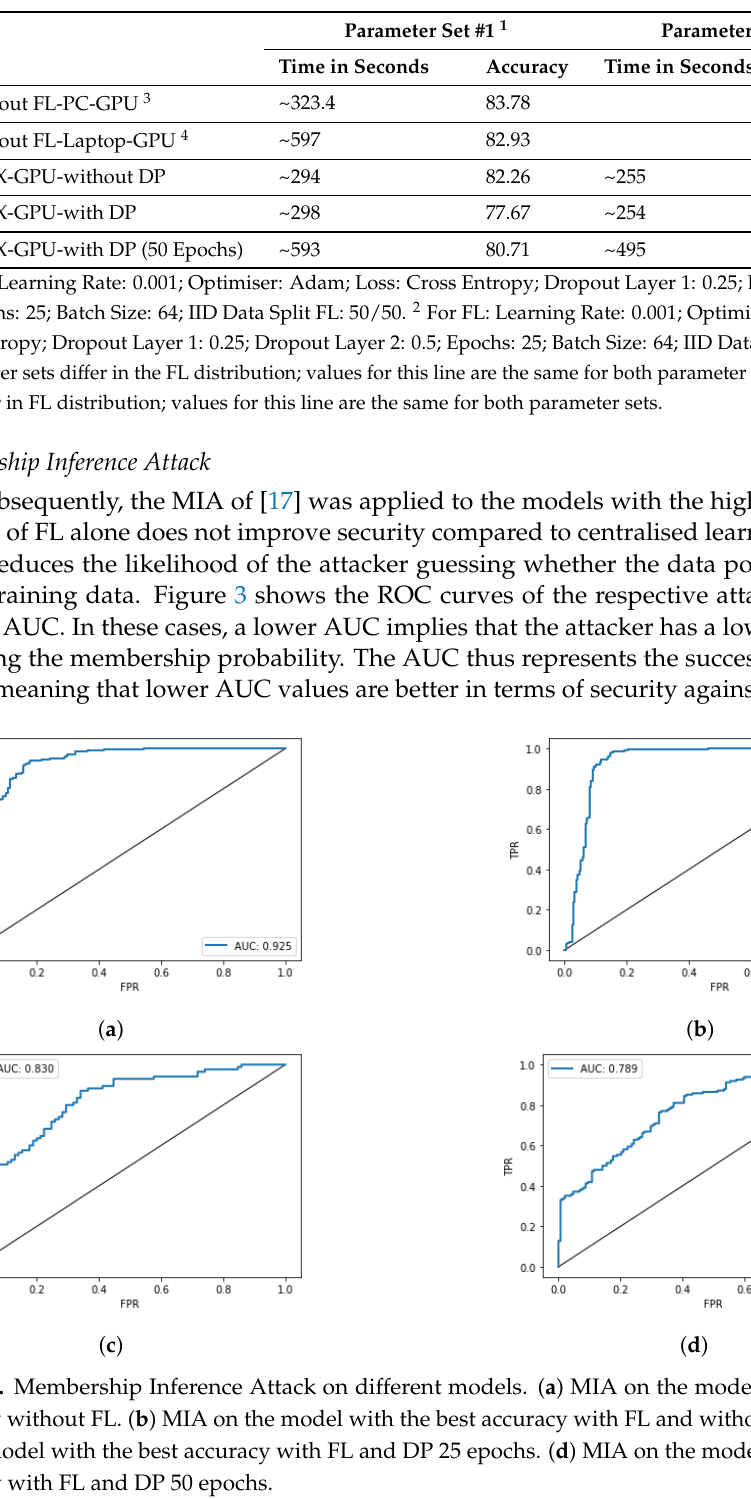
Table 2. Evaluation of the Federated Learning frameworks after ten runs with accuracy and duration.